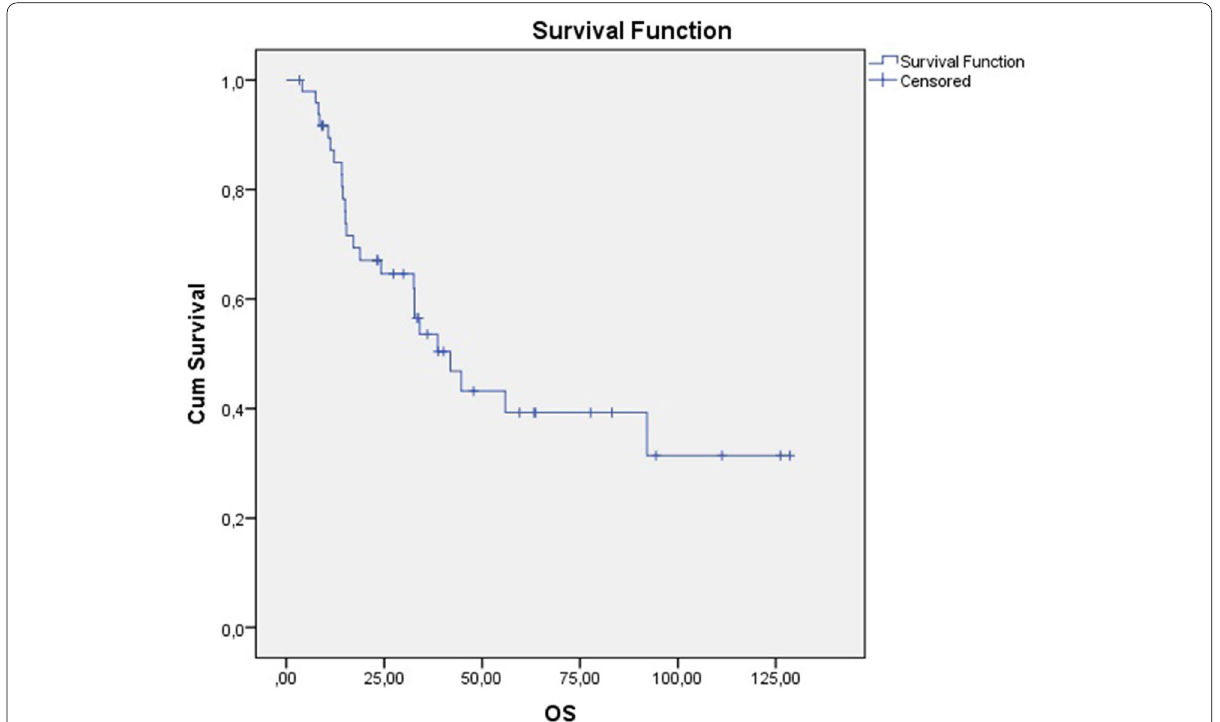
Fig. 2 Kaplan–Meier curve of OS for all